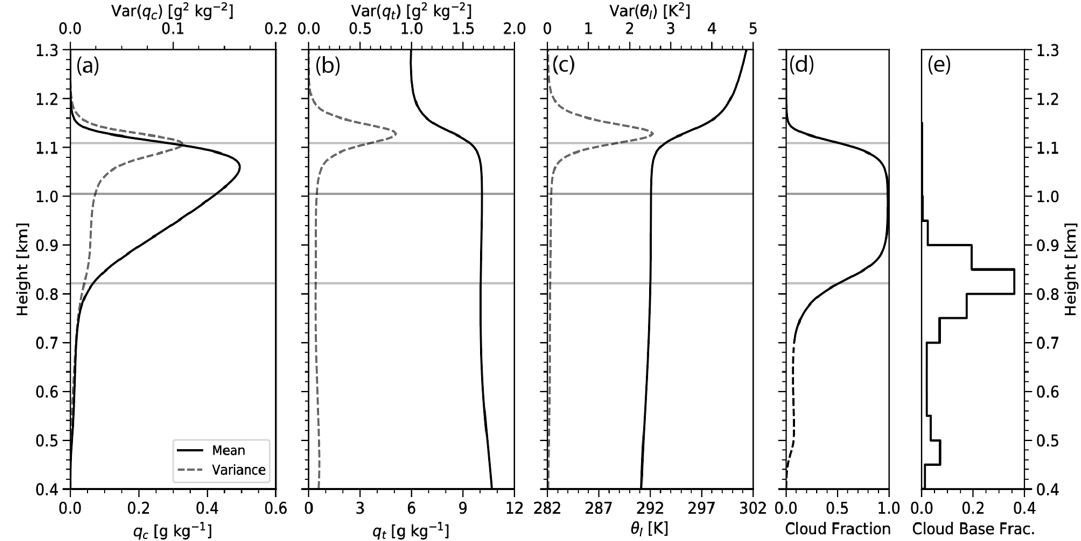
Figure 4. Vertical profile of the horizontal average (mean) and variance, over the analysis period of 09:00–12:00UTC, of (a) the cloud liquid water mixing ratio q c , (b) the total water q t , (c) the liquid water potential temperature θ l , and (d) the cloud area fraction. The solid lines indicate mean quantities, and the dashed lines indicate variance. From bottom to top, the gray lines indicate the mean cloud base, the bottom boundary of the entrainment zone, and the mean cloud top, respectively. (e) Histogram of cloud-base height, with each value representing the area fraction of cloud bases lying within that 50m height interval.